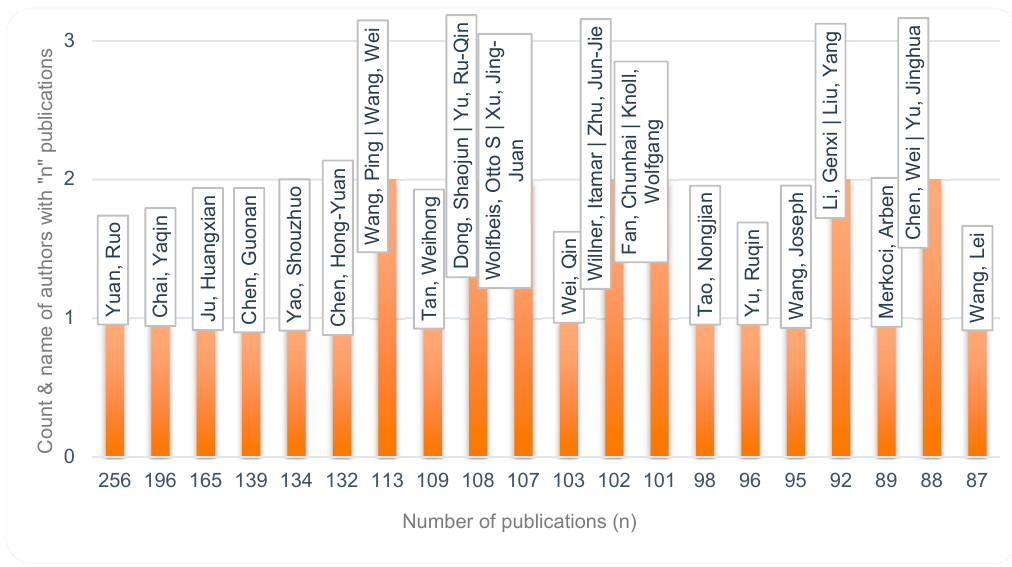
Figure 15. Smaller number of authors with large number of publications - Few authors contribute with many publications on the topic.